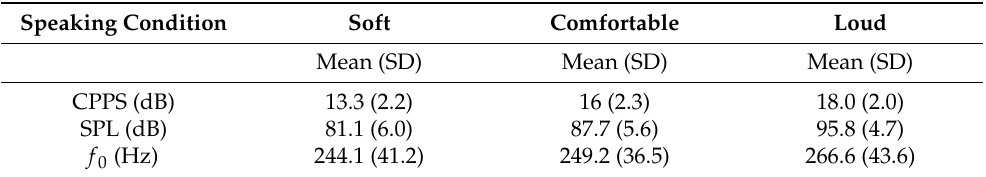
Table 2. Distribution of mean Smoothed Cepstral Peak Prominence (CPPS) (dB) values with standard deviation (SD) (in brackets) for a group of individuals without voice disorders at soft, comfortable, and loud intensity phonation. (Table: own table, derived from